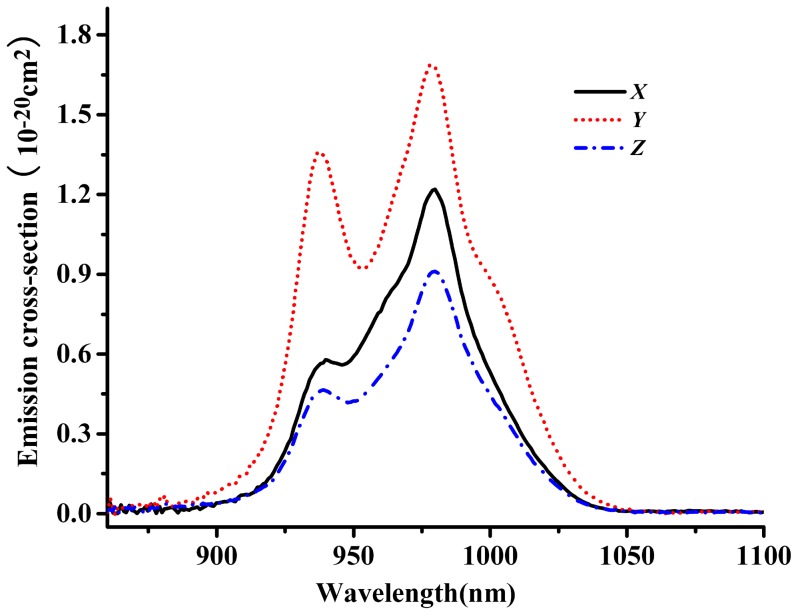
Polarized absorption cross-section of Yb3+:KBaGd(MoO4)3 crystal at room temperature.